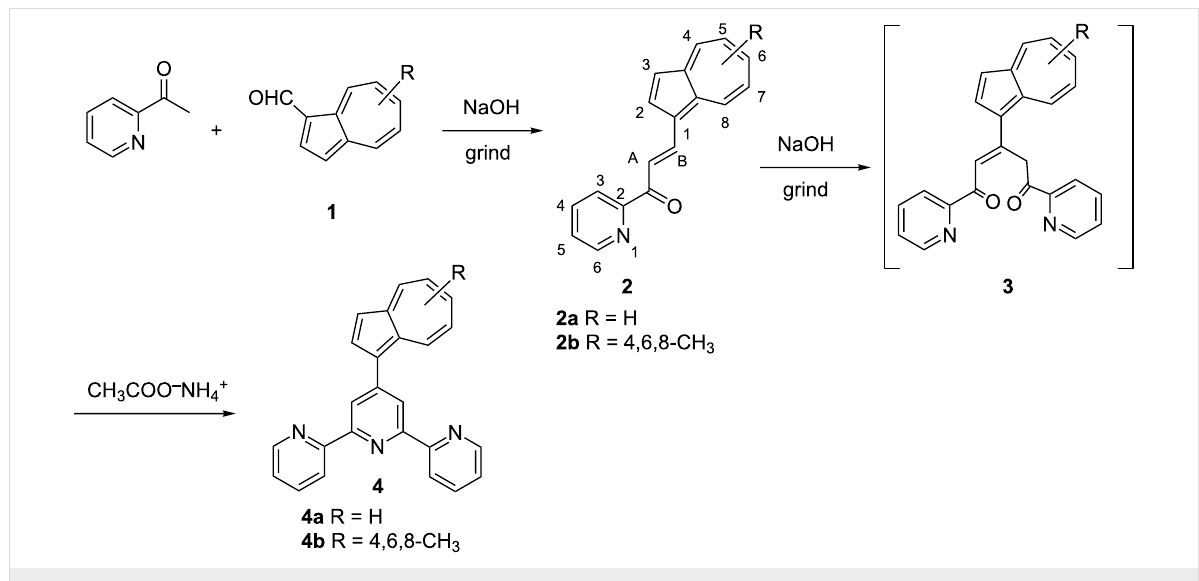
Scheme 1: Synthesis of 4 ′ -azulenyl substituted